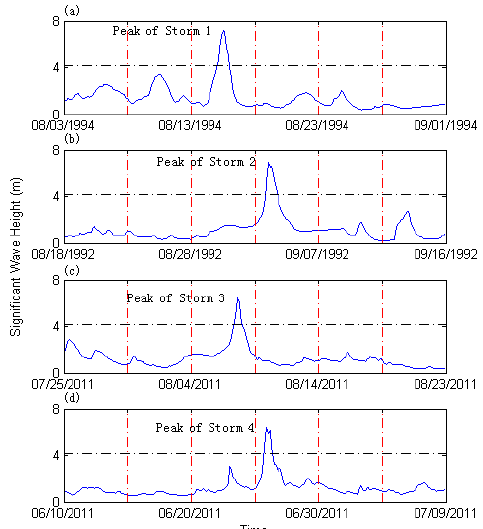
Figure 2. Time series significant wave heights of location S1 in the 720-hour period, covering ( a ) storm 1, ( b ) storm 2, ( c ) storm 3 and ( d ) storm 4.